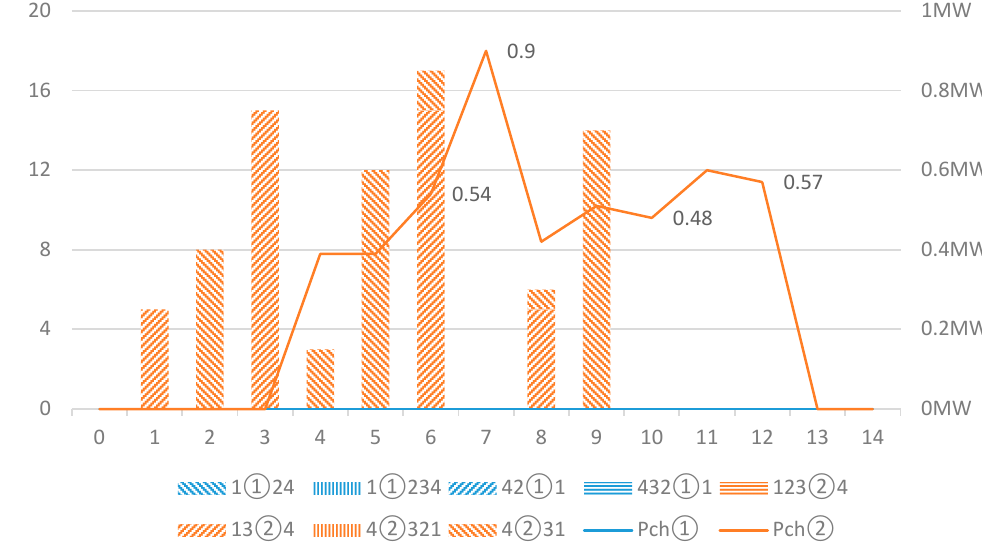
Figure 11. ( a ) Instantaneous flow of task 1 for time period 0 to 10 under PDN prior; ( b ) instantaneous flow of task 2 for time period 4 to 14 under PDN prior.